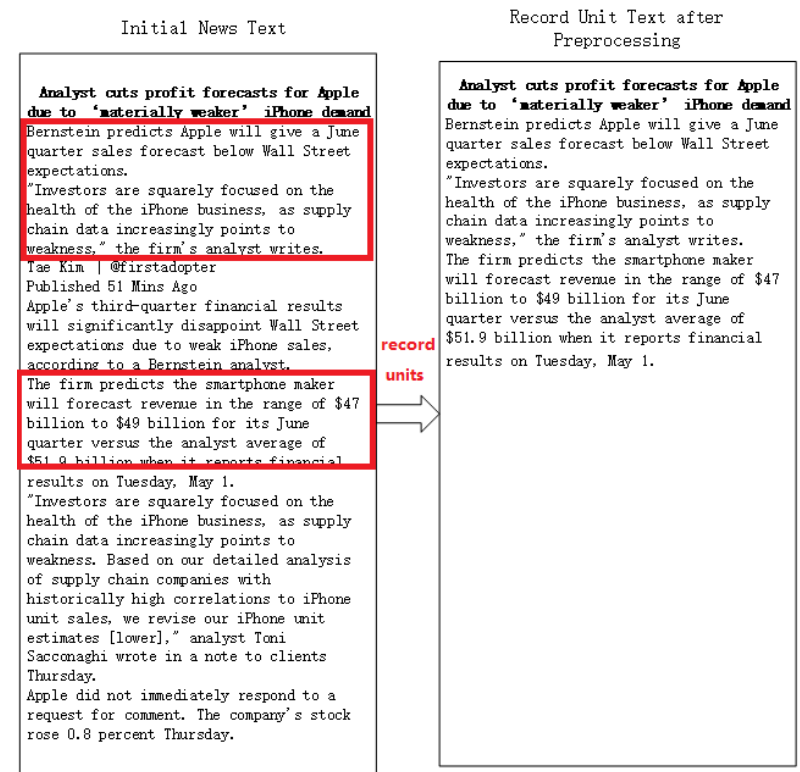
Figure 4. An example of news text and its record unit text after